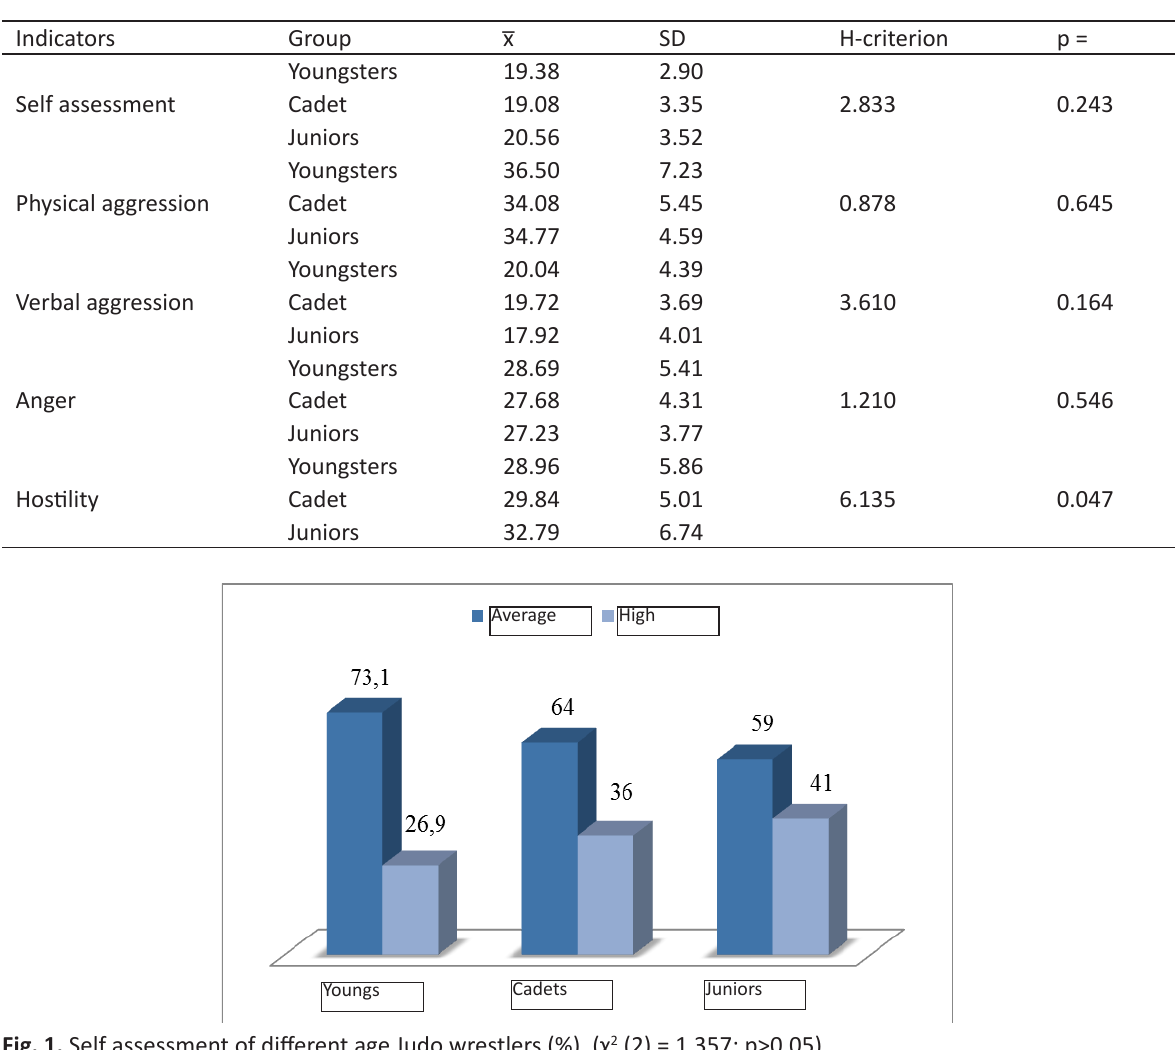
Fig. 1. Self assessment of different age Judo wrestlers (%). (χ 2 (2) = 1.357;